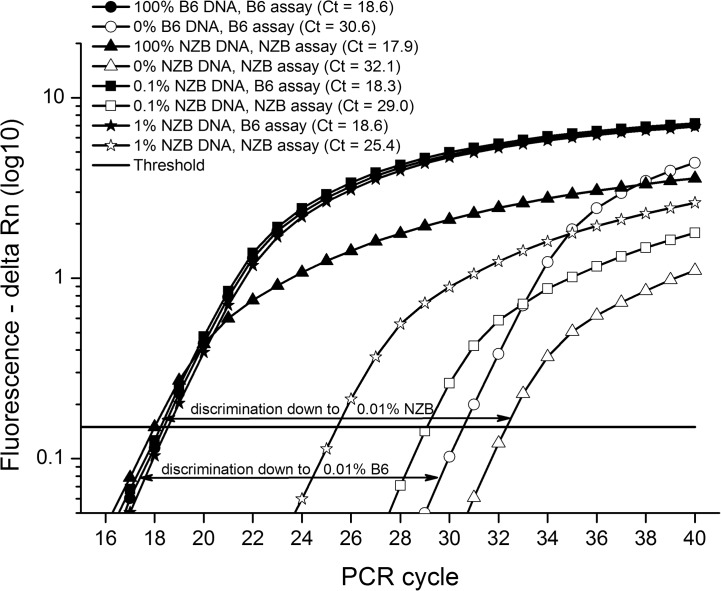
Specificity of the ARMS-qPCR approach for amplification of target mtDNA.Using samples from homoplasmic mice (either NZB or B6), non-specific amplification of non-target mtDNA accounted for only 0.01% of target amplification. Analysis of samples from heteroplasmic mice showed that levels as low as 0.1% of mtDNA of NZB or B6 origin could be detected. Individual Ct values (cycle at which plots crossed the threshold) are denoted in the inset.